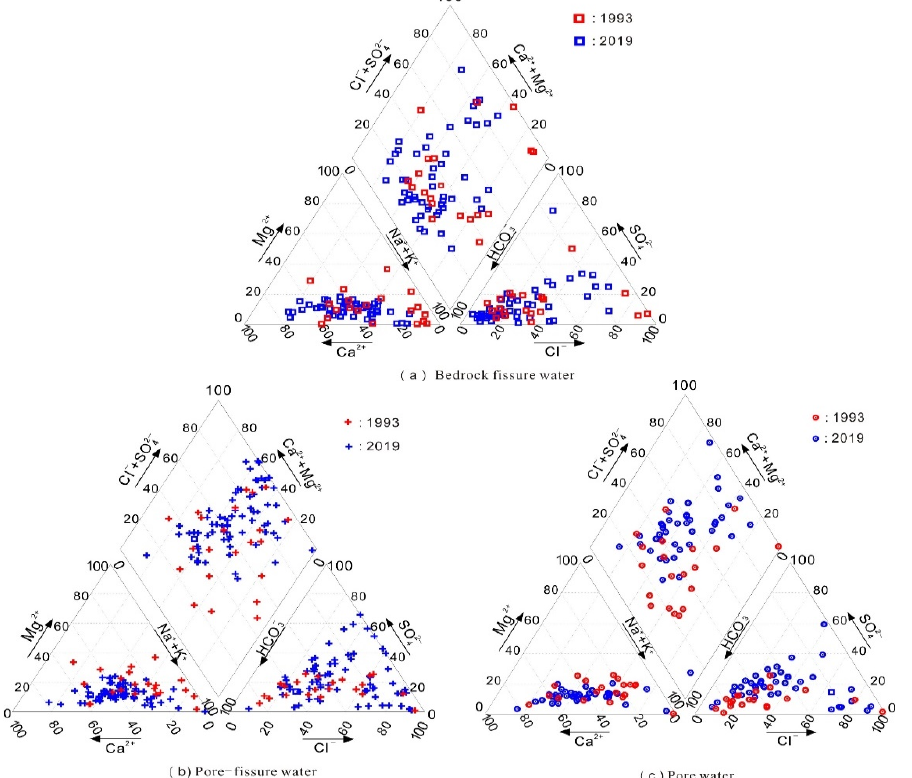
Figure 3. Piper trilinear diagrams.